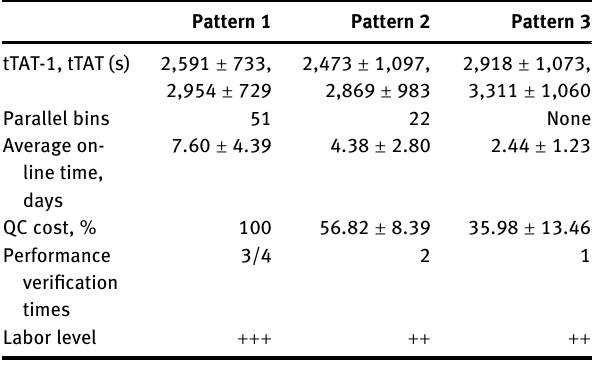
Table  : The simulation results for Pattern  , Pattern  and Pattern  .